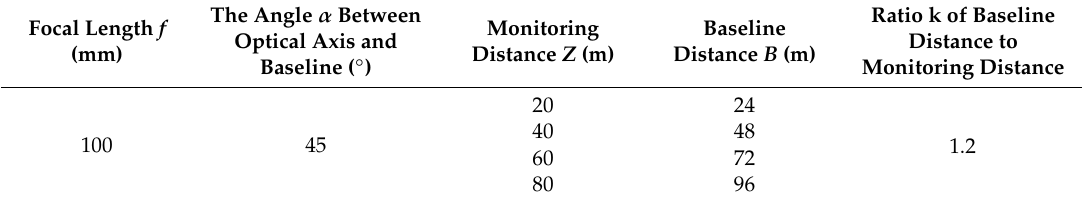
Figure 12. General arrangement of field tests. Table 4. The designed combination of structure parameters.